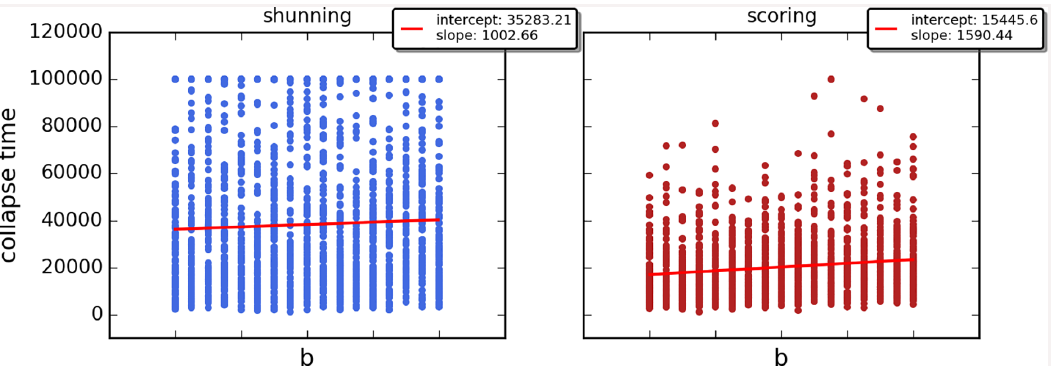
Fig 3. The time elapsed till the collapse of cooperation, BETA6. The figure shows the average time until the collapse of cooperation as a function of the value of the benefit ( b ) for different social norms in the third scenario (BETA6). Each symbol represents the collapse time of a single run; parameters are as follows: n = 100, c = 1, α = 1, β = 6, MST = 80%. Regression lines were fitted to visualize the relationship between collapse times and b .